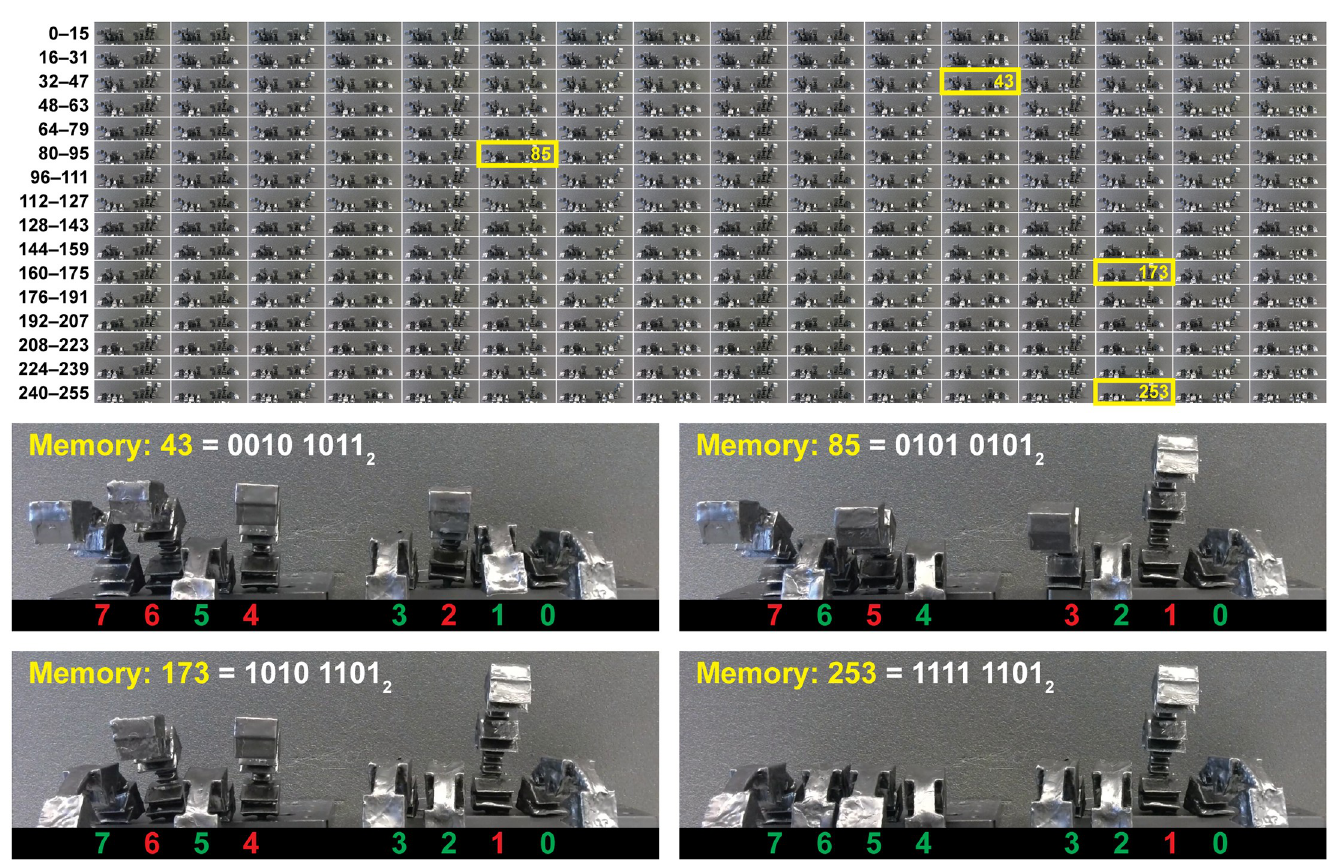
Fig 8. Video frames from using the pneumatic RAM to set eight soft robotic fingers to all 256 different possible patterns, ranging from all extended (corresponding to a value of 0000 0000 2 or 0 stored in the pneumatic RAM) to all contracted (a value of 1111 1111 2 or 255 stored in the pneumatic RAM), with closeups of the fingers while the pneumatic RAM is storing the values 43, 85, 173, and 253. Closeups of all 256 frames are available as Supplementary Information .